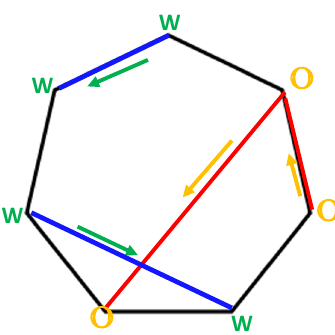
Figure 9 . The counterclockwise oriented heptagon for octonion notations in eq. (4.25). We start at the second right octonion and call it e r +1 , we get the 7 associative triads in the form as ( r + 1 , r +2 , r +6) . The complimentary quadruples are ( r +3 , r +4 , r +5 , r +7) . They are shown by the corners of the oriented counterclockwise 2 blue lines. These give WO oriented